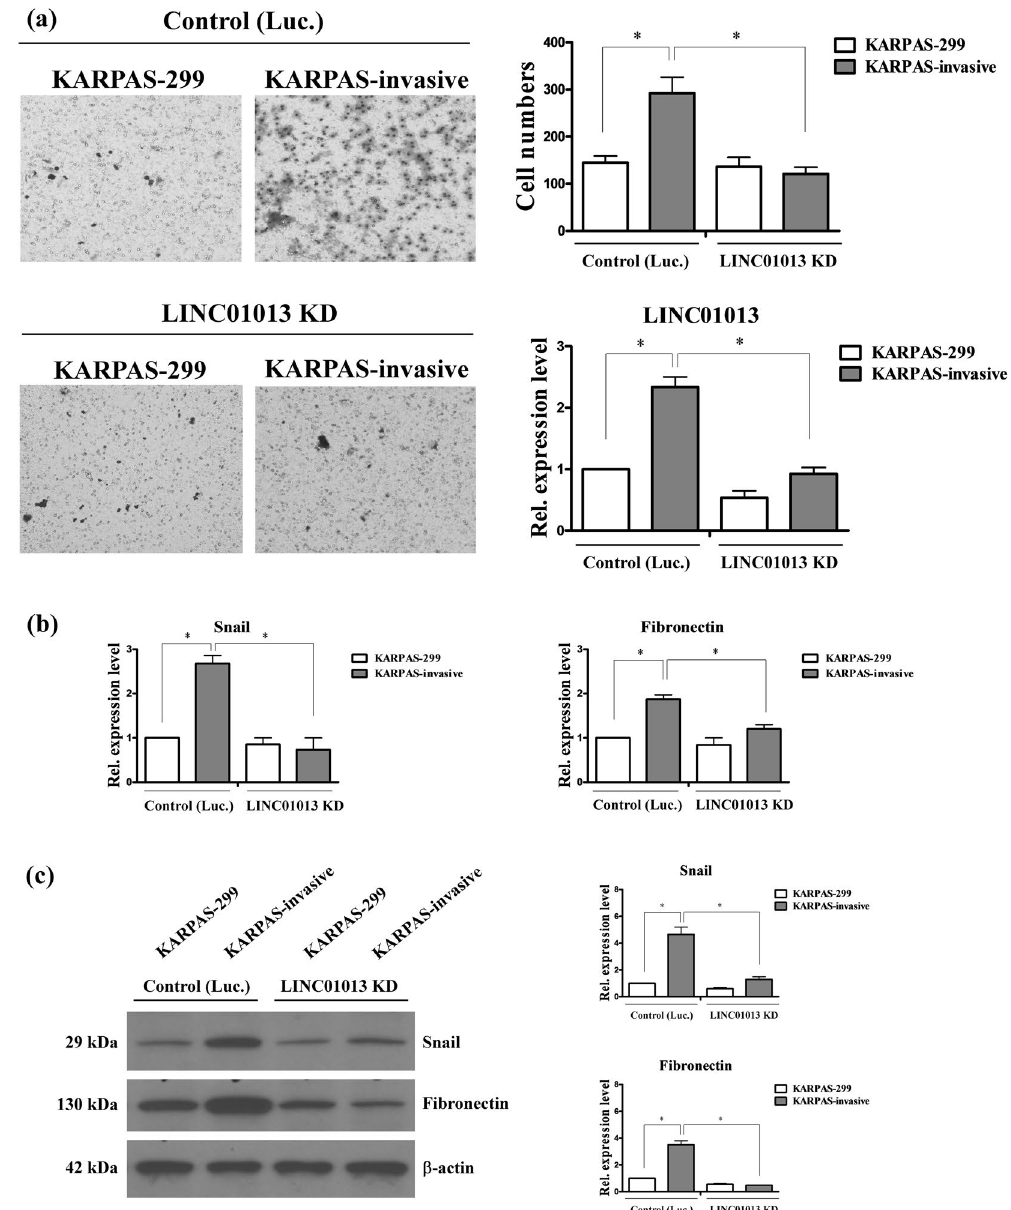
Figure 3. LINC01013 depletion suppresses ALCL cell invasion. ( a ) Left panel : The invasion ability of KARPAS-299 and KARPAS-invasive cell lines was analyzed using Transwell assays under LINC01013-depleted (LINC01013 KD) and control (Luc.) conditions. Right panel : Quantification of invasive ability and LINC01013 expression levels. ( b ) Snail and fibronectin expression levels in these cell lines were determined by q-RT-PCR ( c ) and Western blot analysis. Differences were analyzed using a Kruskal-Wallis test ( * P <